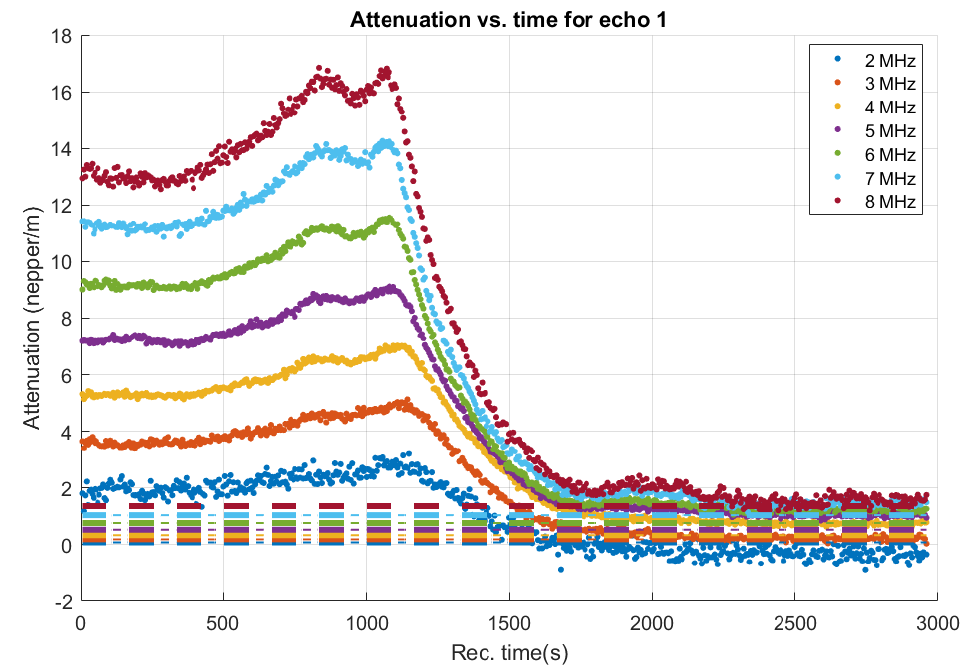
Figure 5. Attenuation vs. frequency for the first transmitted echo. The reference fluid is depicted in dashed lines with the same color legend.